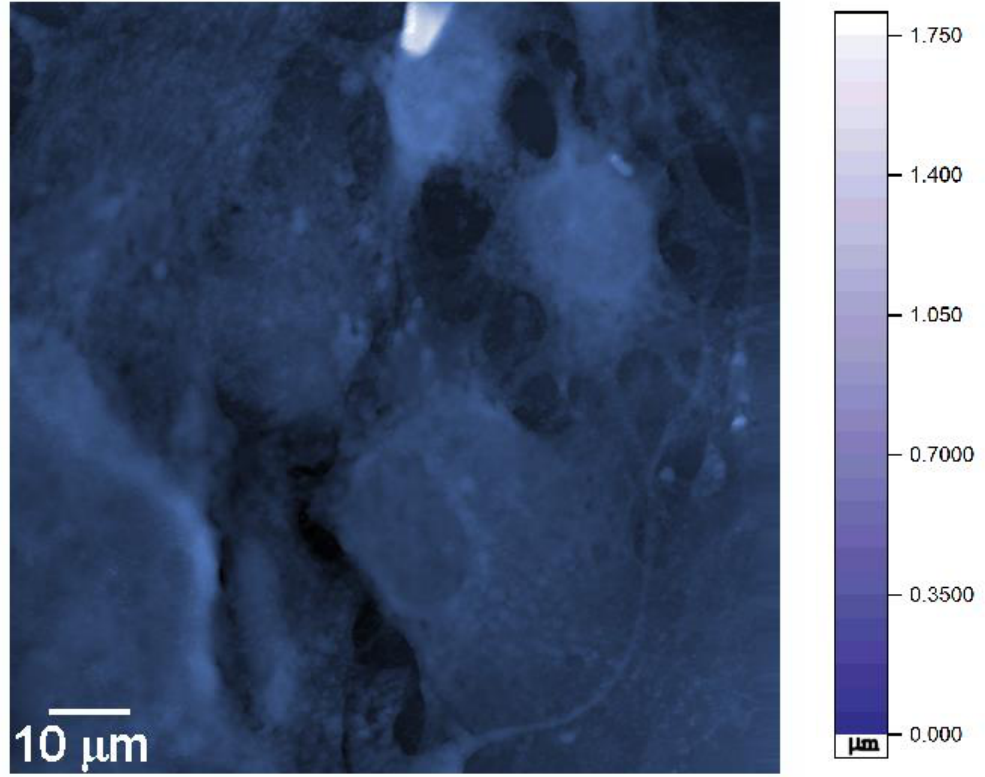
Figure 1. The randomly taken atomic force microscope (AFM) image of hMSCs challenged with HAp nanoparticles, used as the starting point for inquiry into the interaction between nanoparticles and cells.